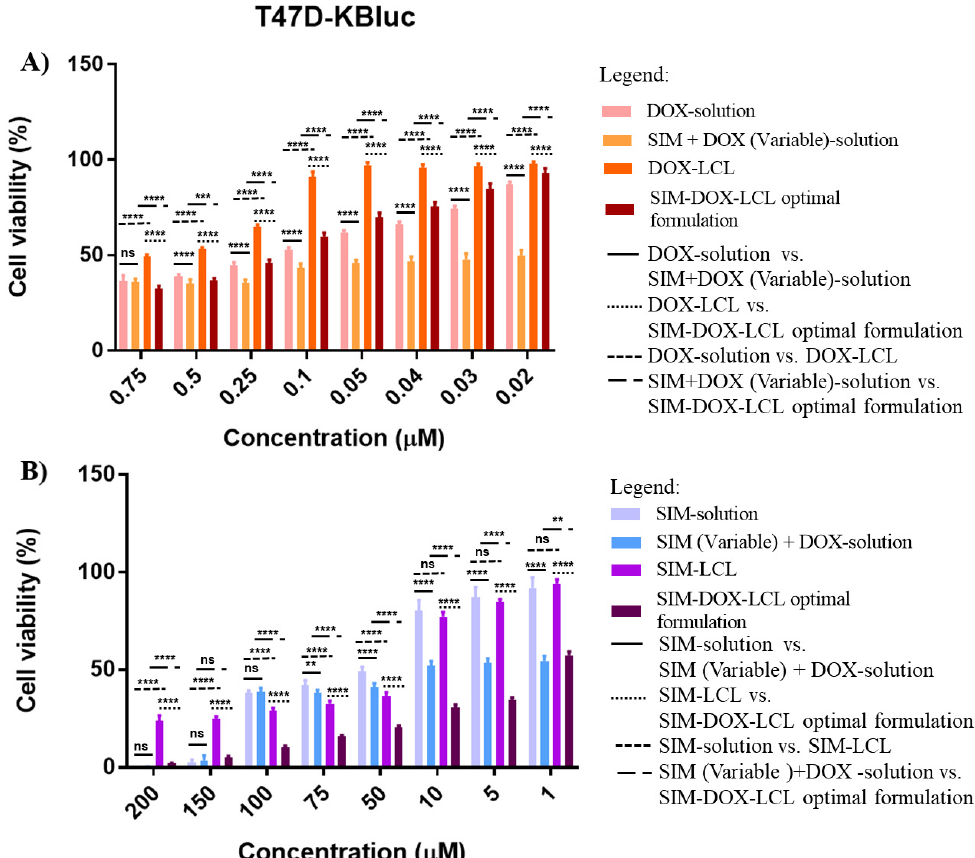
Figure 10. The effects of DOX ( A ) and SIM ( B ) treatments as monotherapy or in combination, on the proliferation of T47D-KBluc human mammary ductal carcinoma cell line. ns: not significant ( p -value > 0.05); ** : p -value < 0.01; *** : p -value < 0.001; **** : p -value < 0.0001.